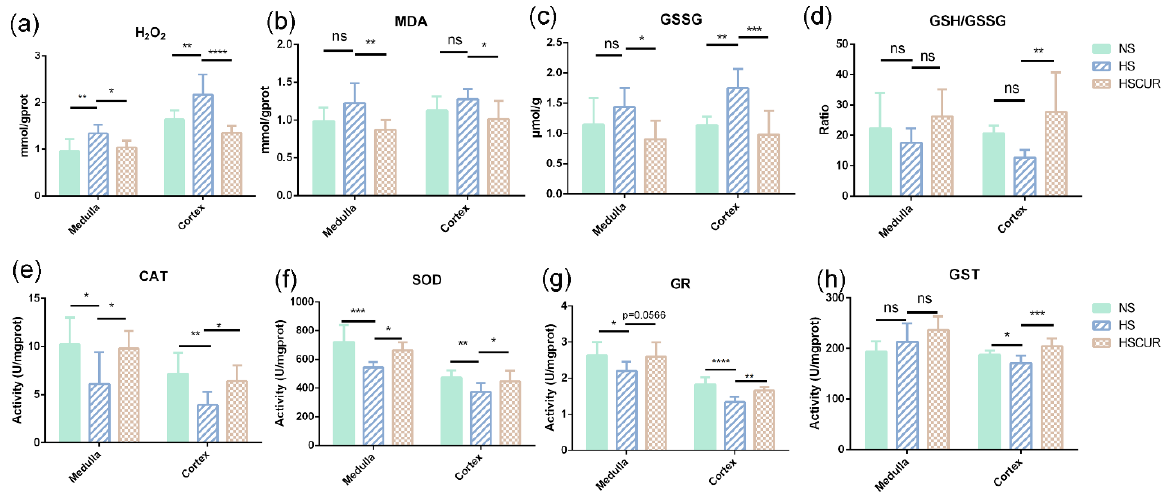
Figure 10. Effect of curcumin on REDOX balance in the kidney of SS rats after HSD feeding. Hydrogen peroxide (H 2 O 2 ) levels ( a ), malonaldehyde (MDA) levels ( b ), oxidized glutathione (GSSG) levels ( c ), reduced glutathione/GSSG ratio ( d ), catalase activity ( e ), superoxide dismutase activity ( f ), glutathione reductase activity ( g ), and glutathione S-transferase activity ( h ). ns denotes non significance, **** p < 0.0001, *** p < 0.001, ** p < 0.01, * p < 0.05, and p -value was determined by one-way ANOVA test followed by Tukey’s test.